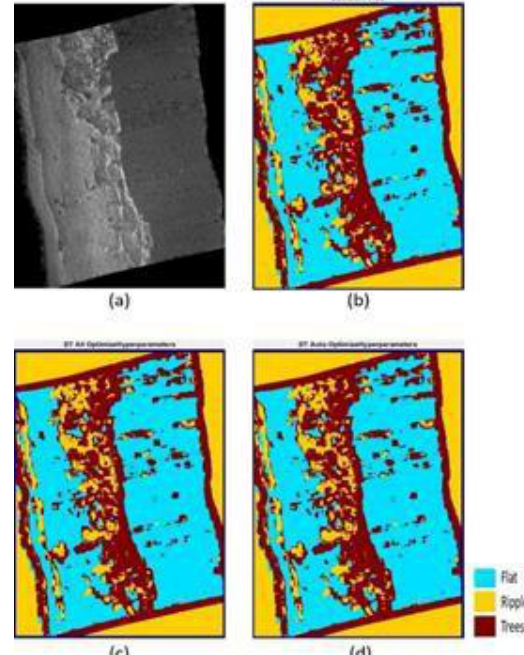
Figure 7. Result of Decision Tree classification: (a) Original image, (b) Default option of DT, (c) DT with all-optimised hyperparameter, (d) DT with auto-Optimised